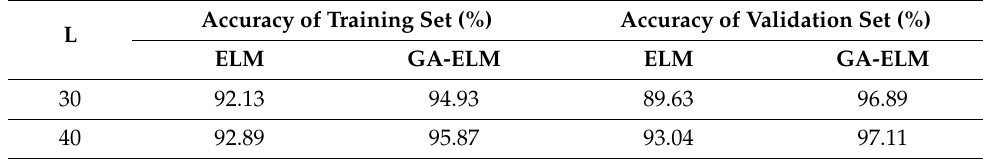
Table 4. Results of comparison between the GA-ELM and ELM